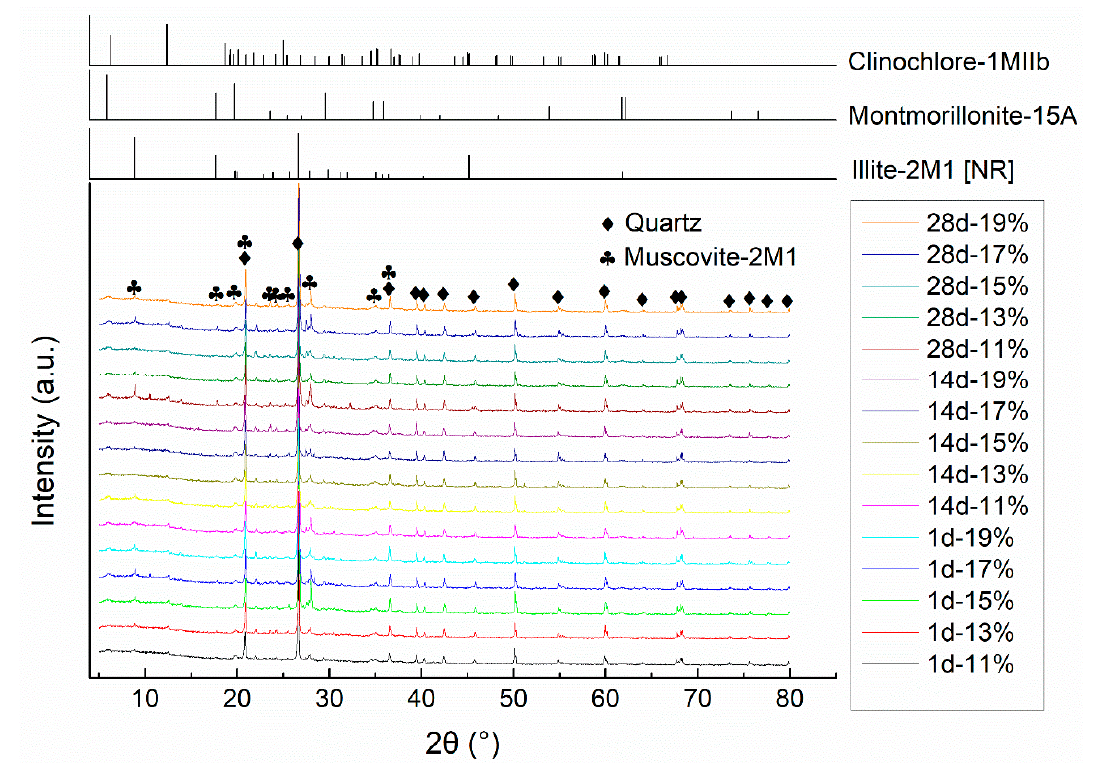
Figure 17. Effects of initial water content on mineral composition.